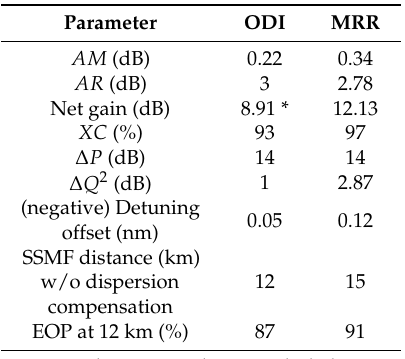
Table 1. Values of employed performance